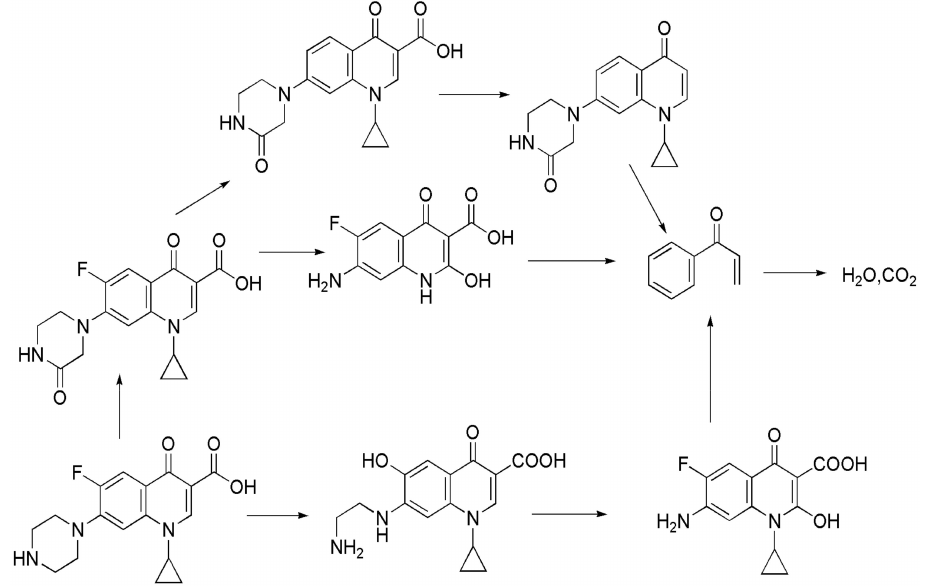
Figure 7. The mechanism of the photocatalytic degradation of CIP over the kaolin / CeO 2 / g- C 3 N 4